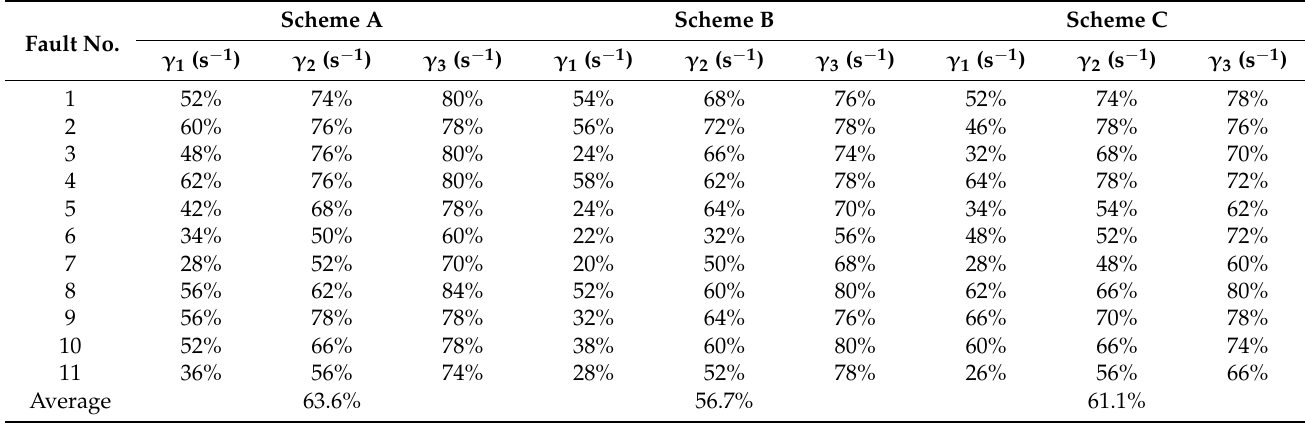
Table 13. Fault detection rates for incipient faults.